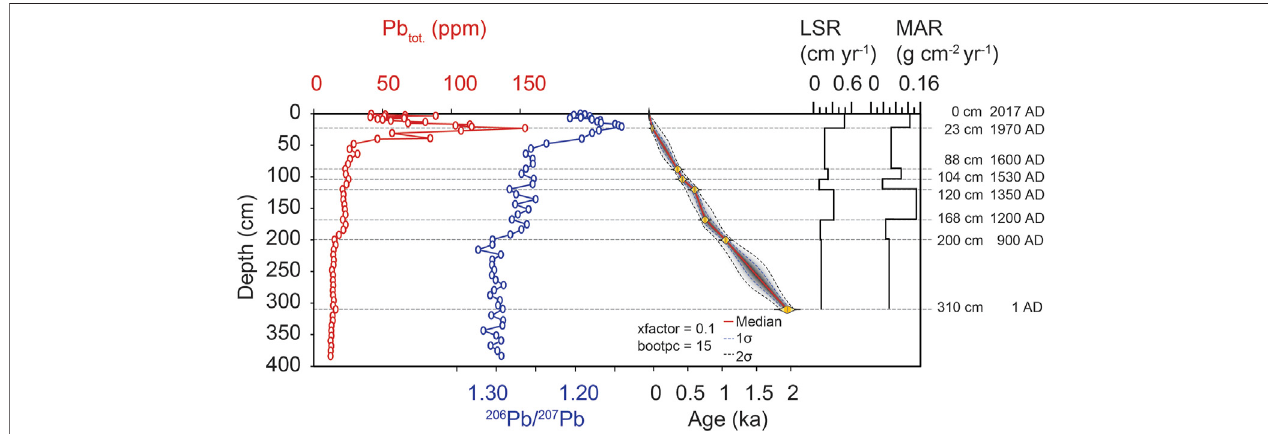
FIGURE2| Constructionoftheage vsdepthmodel fortheStorfjärdensite. NotethatAge0ka (cid:2) AD1950.The fi gure combinesdatafromtheGEMAXcoreofApril 2015(0 – 40 cm)and thepistoncoreofSeptember 2017(40 – 400 cm). Seven tie-points inthePb tot pro fi le (red), inaddition tothesediment-waterinterface, wereused to constrain the chronology based on temporal changes in anthropogenic Pb deposition (Brännvall et al., 1999; Jokinen et al., 2018). The Undatable software generates a probability-densitycloud(greyshaded region,note1 σ and2 σ windows)betweenthetie-points. Ageanddepthuncertaintyofthetie-pointsthemselvesisindicated by the yellow symbols. The 206 Pb/ 207 Pb pro fi le is shown for comparison. Note that these data were not used to constrain tie-points due to observed low signal-to- noise ratio.